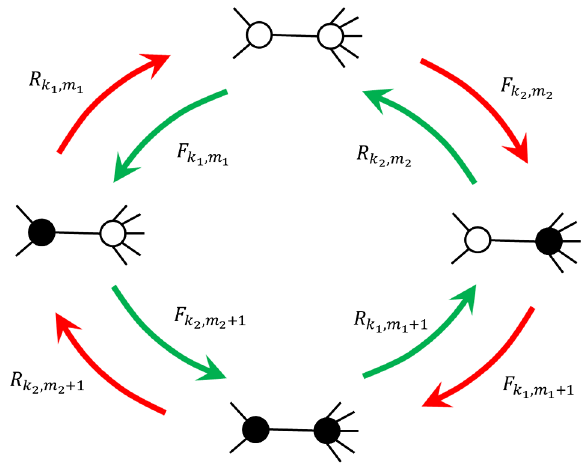
FIG. 10. Rates for state transitions of a connected pair of nodes, assuming that the states of all their other neighbors and remain unchanged. Node 1 (left-hand node) has degree k 1 infected neighbors that are not shown. Node 2 (right-hand has m 1 and has m neighbors—other than node node) has degree k 2 2 1—that are infected.